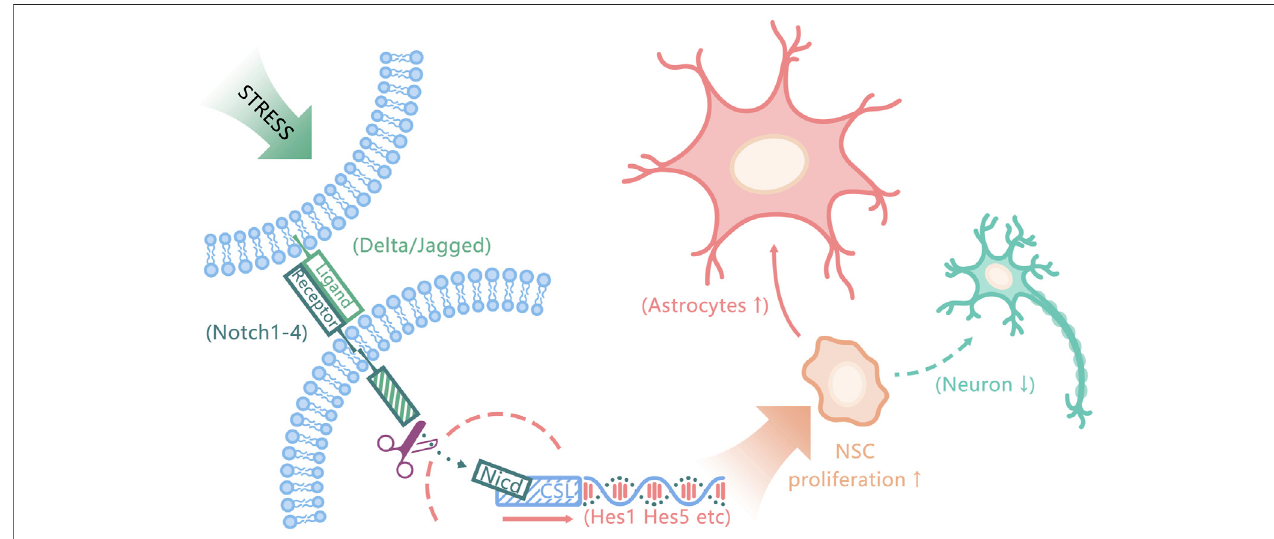
FIGURE 11 | Schematic diagram of molecular pathological mechanism of generalized anxiety disorder. Chronic stress activates Notch signaling pathway, which promotes the proliferation of neural stem cells and massive transformation to astrocytes, resulting in impaired neuronal regeneration (Louvi and Artavanis-Tsakonas, 2006).